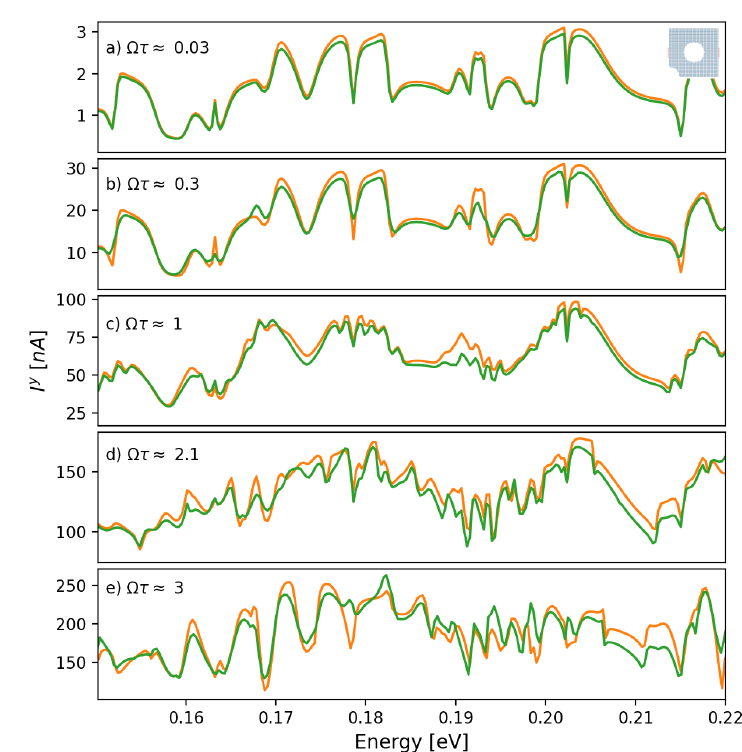
Figure 4: AC spin currents generated by the time-dependent Rashba SOI in the ab- sence of any charge bias are plotted as a function of the Fermi energy. The numerical Floquet results (green) are compared to the spin current in y direction in the pres- ence of the time-dependent spin voltage (orange). The spin currents (orange) are calculated using Eq. (41) in the low-frequency regime in panels a) and b) and by Eq. (47) in the high-frequency regime in panels c), d) and e). The system size is ( t ) = k L = 50 a and the Rashba SOI is α L = 1. The frequency sin ( Ω t ) with k R so so values are indicated at the top left corner of each panel, Ω τ ≈ 0.03, 0.3, 1, 2.1 and 3 in panels a) and b), etc., respectively. The system geometry is shown in the top right